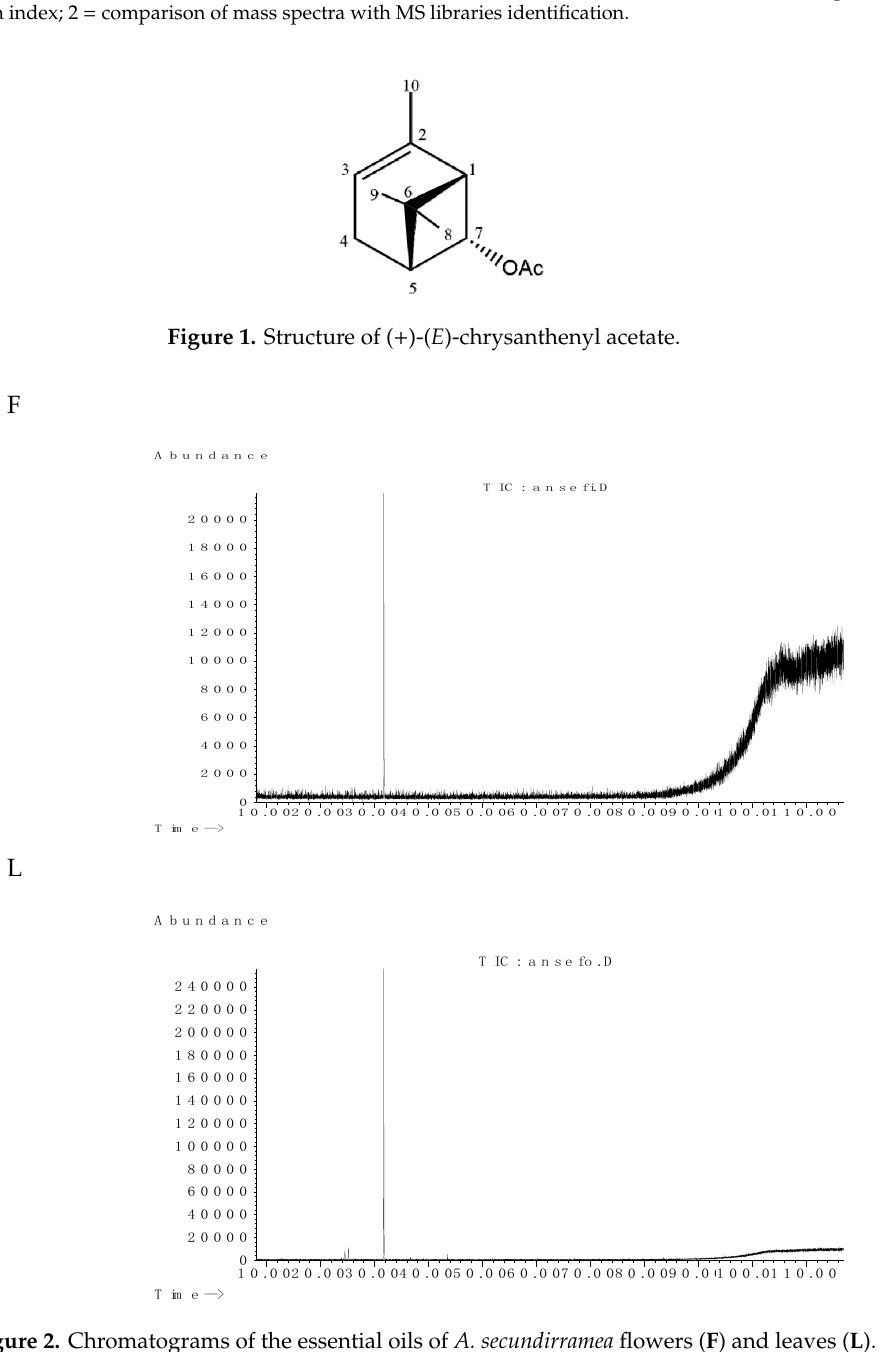
Figure 2. Chromatograms of the essential oils of A. secundirramea flowers ( F ) and leaves ( L ).